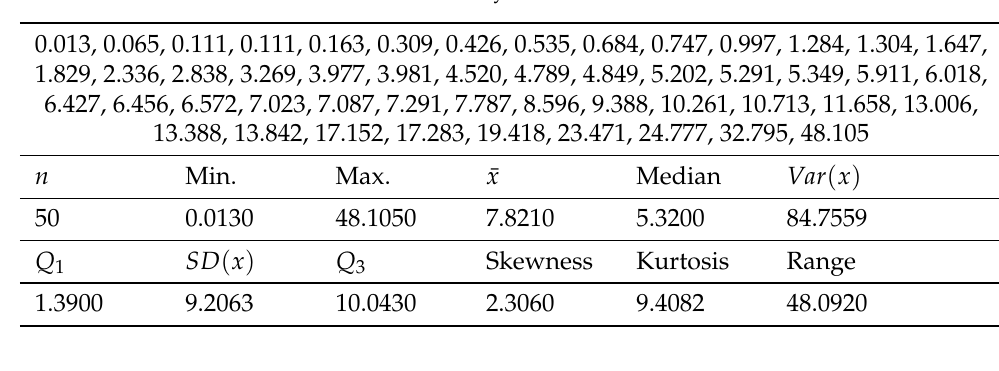
Figure 10. Using the flood peaks data set, the visual comparison of the fitted models. Table 7. The failure times data set with summary